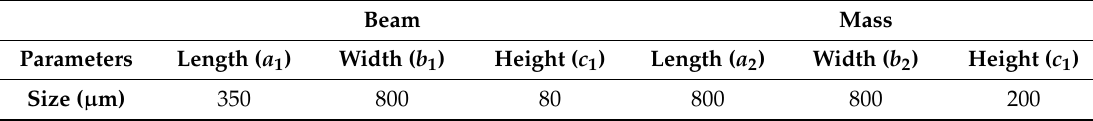
Table 1. Structural parameters of the